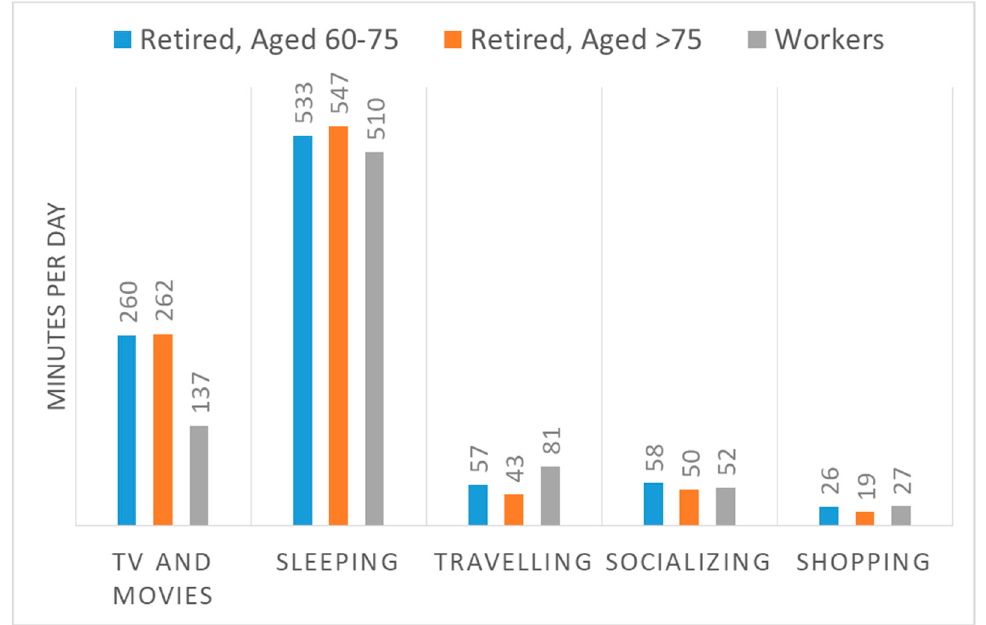
Figure 5. Retired persons: Average total time spent per day on select activities—retirees >75 years old versus 60–75 years old. Time spent by workers (all ages) is displayed to show differences between working and retired time use patterns.